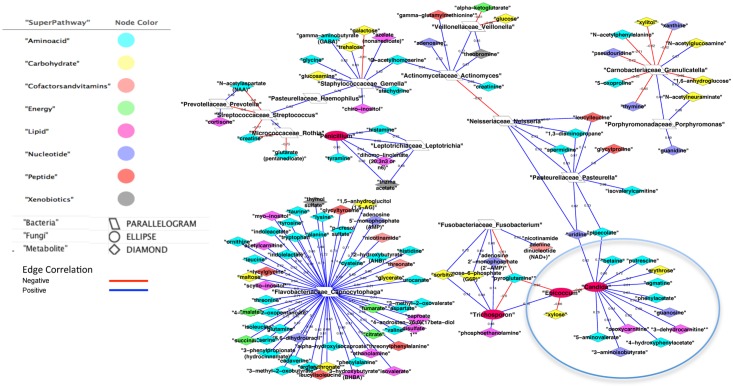
MBF HIV cohort significant correlations (rho >0.6 or rho <-0.6).A blue edge depicts a positive correlation; a red edge depicts a negative correlation. The correlation value is listed on the edge. The node shape defines the type; diamond is metabolite, parallelogram is bacteria, and circle for fungi. The location of the node, and the link length, and orientation, is not significant.